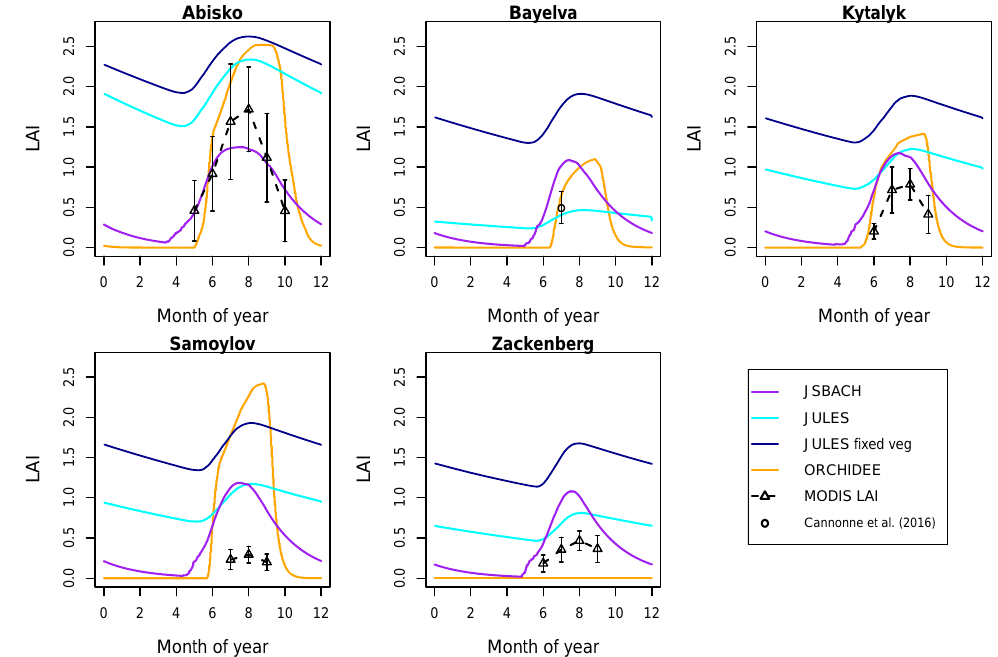
Figure 10. Mean annual cycles of LAI (leaf area index) for each site. Observed values are from the MODIS LAI product (MODIS15A2, 2016), except Bayelva, which is from (Cannone et al.,